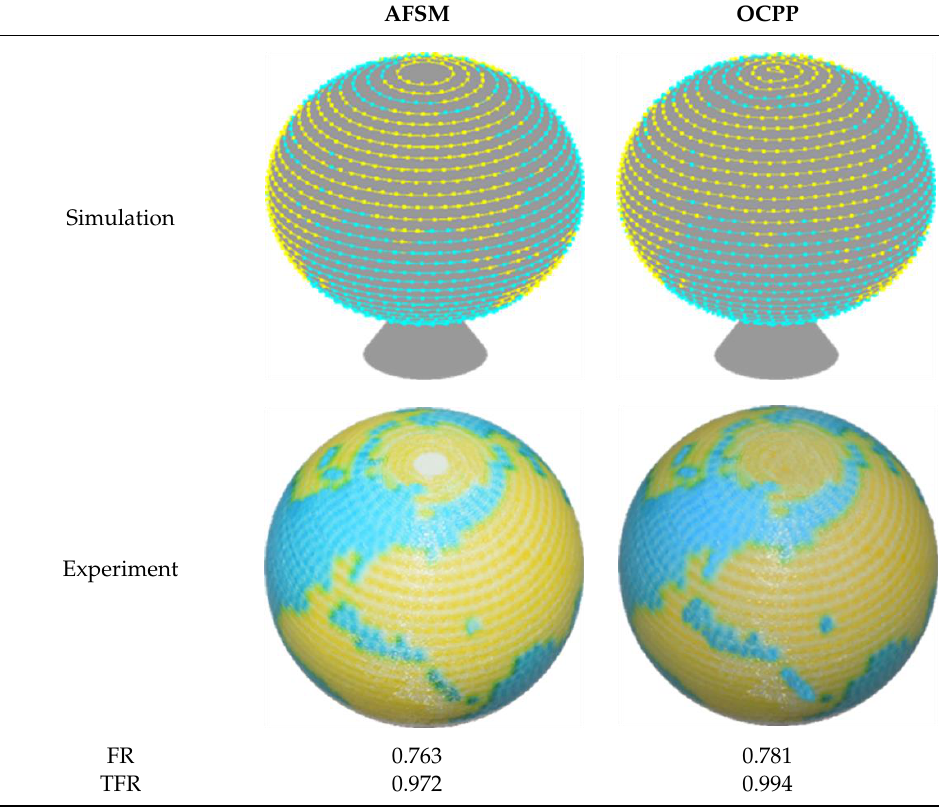
Table 2. Comparison between the AFSM and OCPP for a freeform surface.